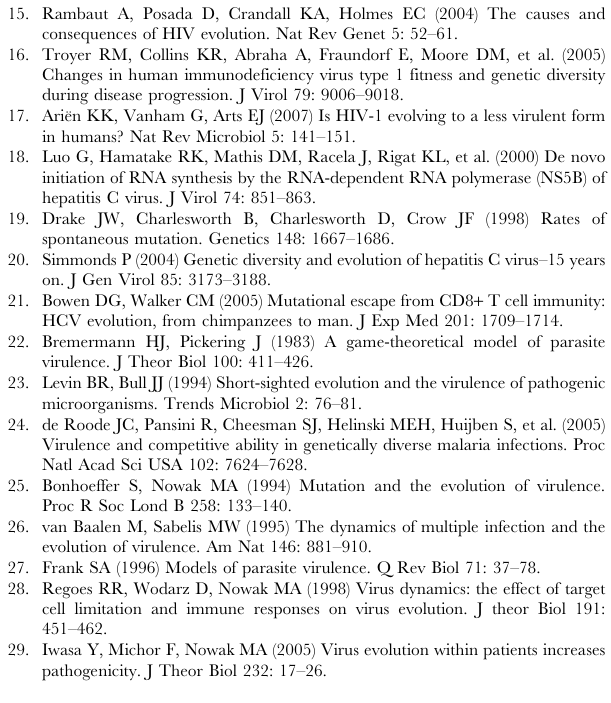
Figure S1 Dynamics of the average replication rate of transmitted strains and of the total number of strains transmitted per day We show the results obtained for 200 simulation runs for low, average, and high cross-reactive immune responses, respec- tively ( q , indicated on the top of each panel). Other parameter values are as in Table 1, and Q = 0.3. The top panels show the replication rates transmitted over time (red dots), and the solid line represent the result of linear regression (A) r 2 = 0.902, B) r 2 = 0.883, C) r 2 = 0.810). Bottom panels show the number of